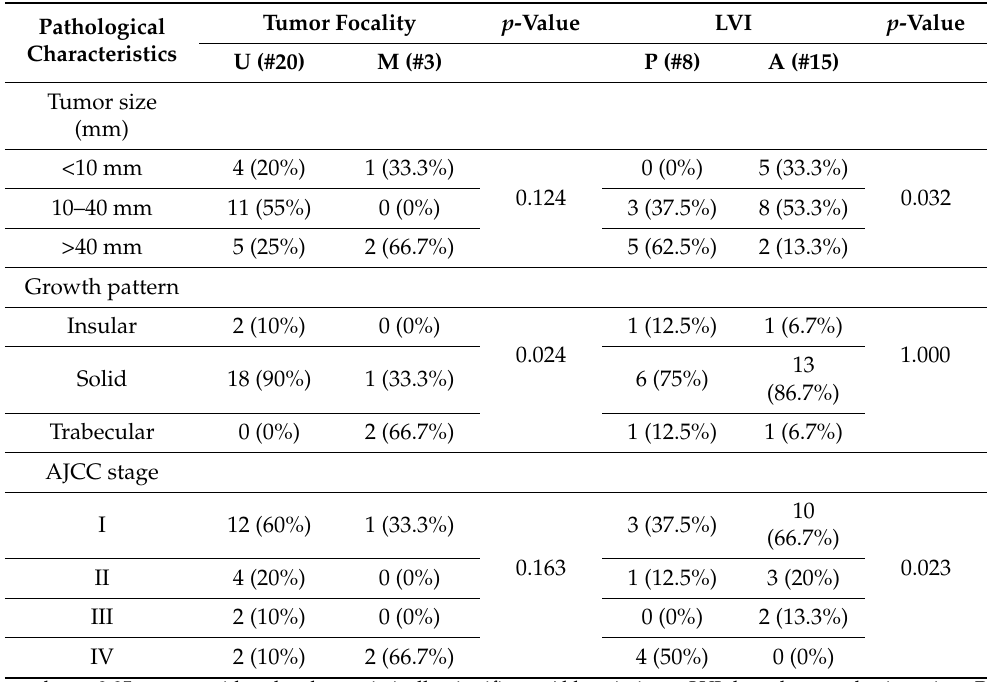
Table 4. Pathological characteristics of the MTC-only tumors in relation to the histopathological prognostic features (Chi-squared